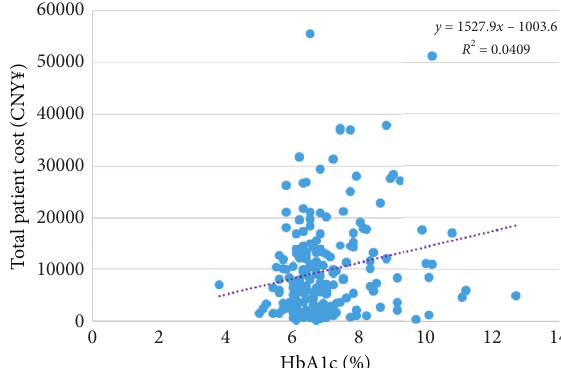
Figure 1: The linear associations between HbA1c and total patient cost. Table 3: Comparison of cost-effectiveness analysis between the mHealth group and usual care group. HbA1c control rate